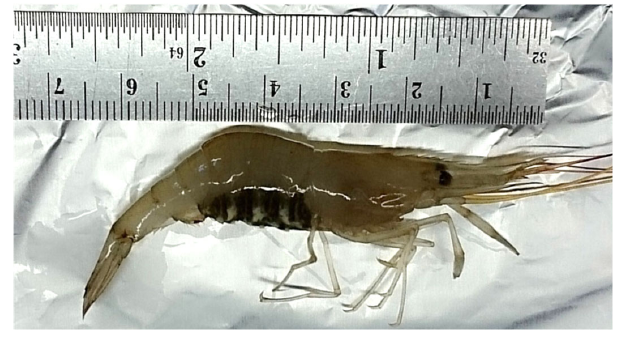
Figure 2. The European common prawn Palaemon serratus.